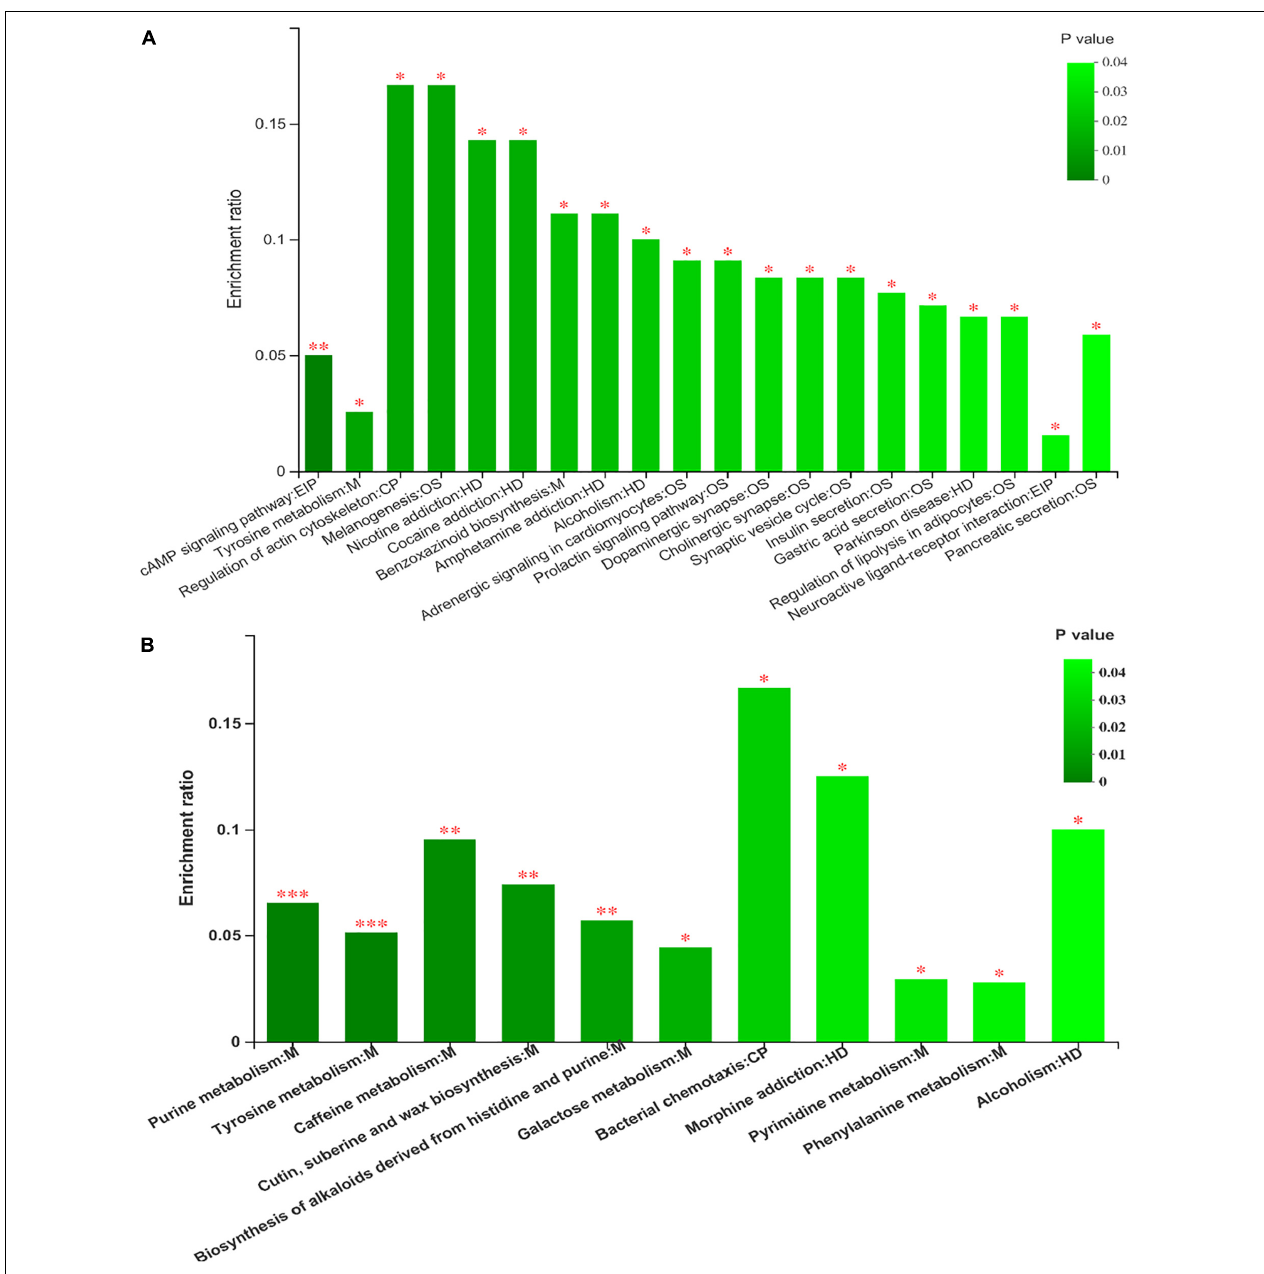
FIGURE 8 | The analysis of different metabolites pathway enrichment (A) positive mode ionization; (B) negative mode ionization. * P < 0.05, ** P <